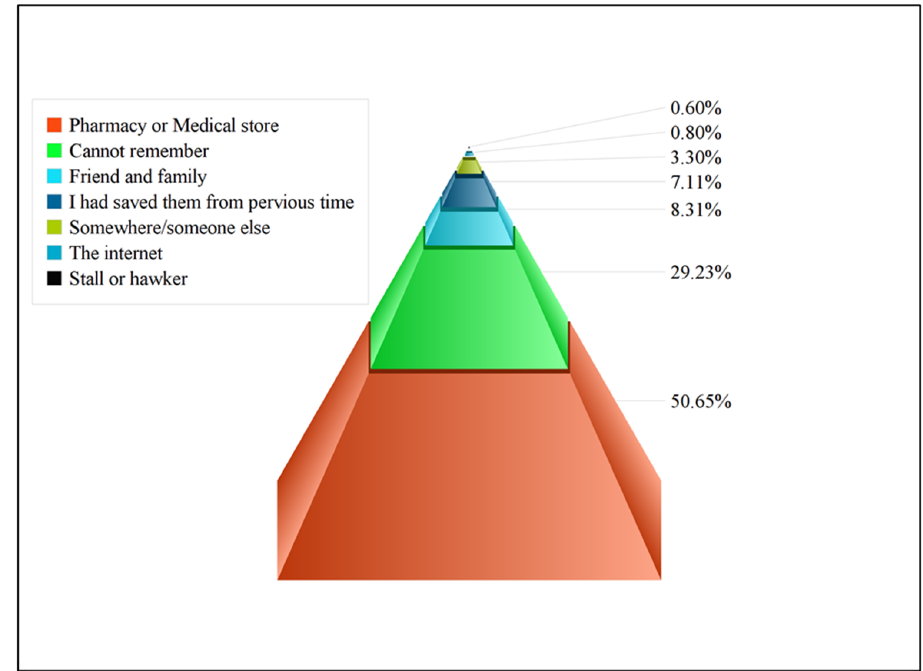
Figure 1. Common sources for obtaining antibiotics in the present study.